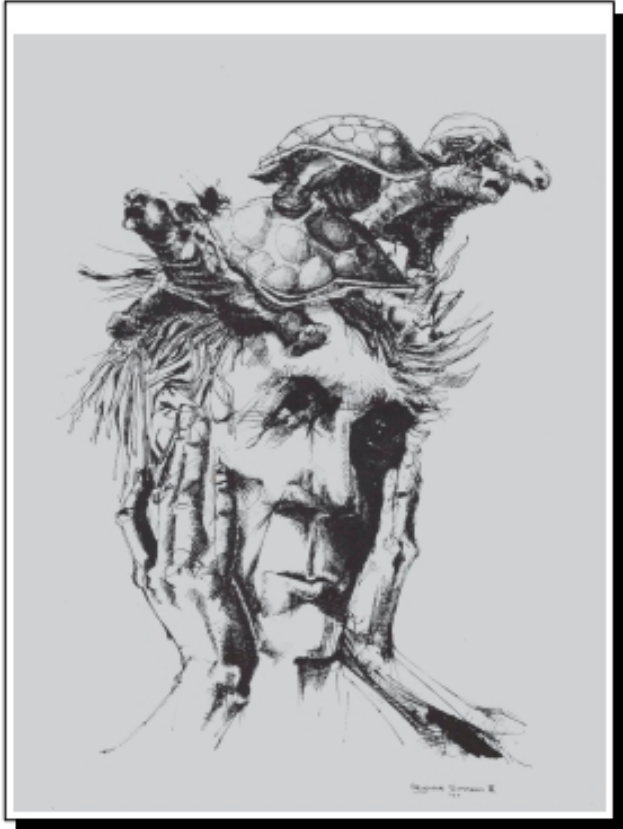
Figure 10. “Turtles” by Seymour Simmons III; an example of “drawing as expression”.